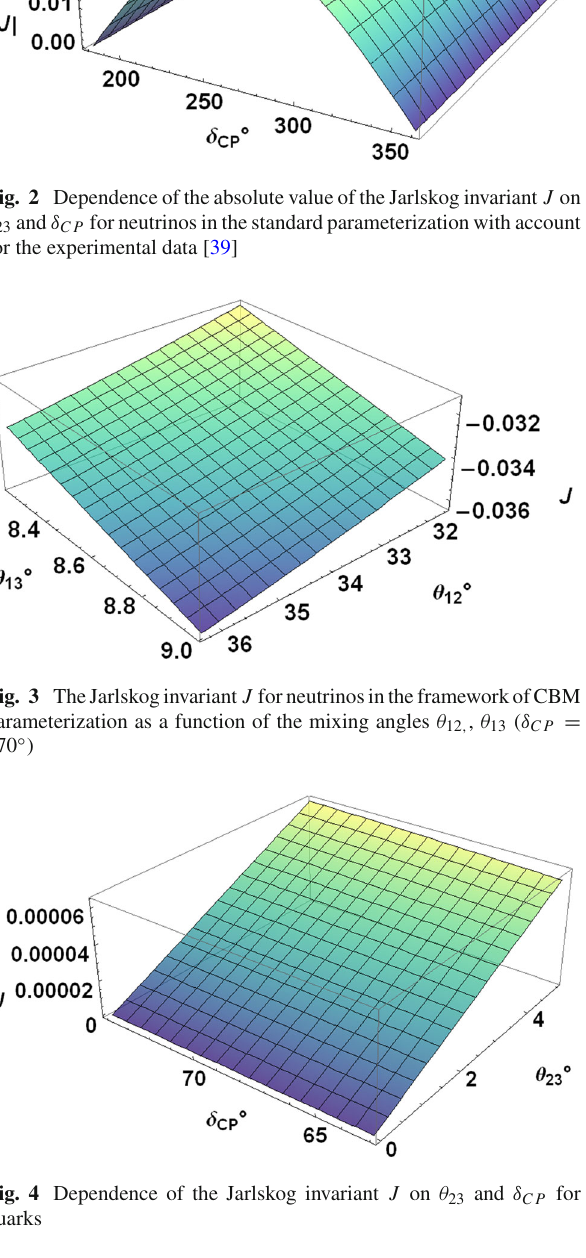
the CBM parameterization (4) ( θ 23 = π/ 4, δ CP = − π/ 2). The plot in Fig. 5 corrects the erroneous result in [51].